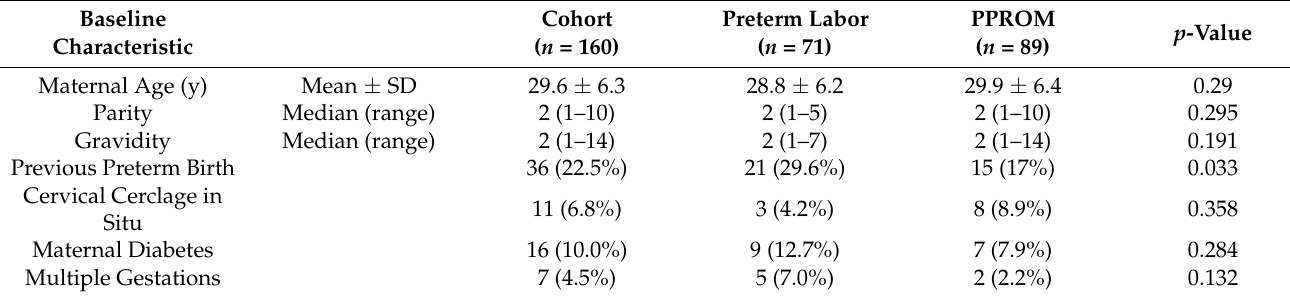
Table 1. Baseline characteristics of women participating in the